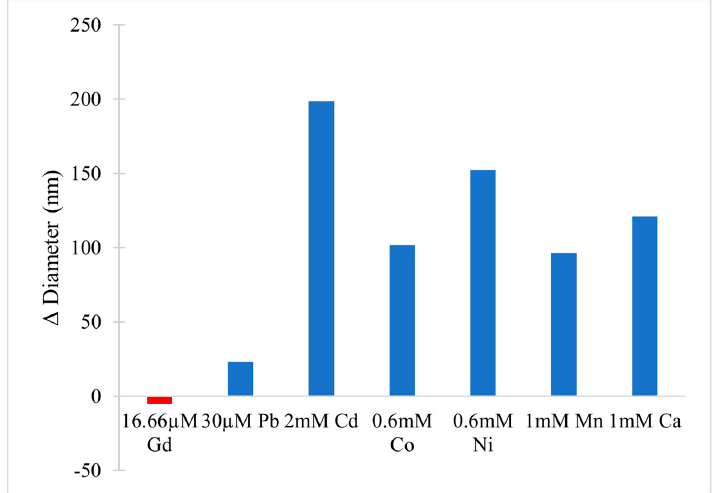
Figure 12. Change in size of POPS liposomes in the presence of various heavy metals. Measured by DLS. by